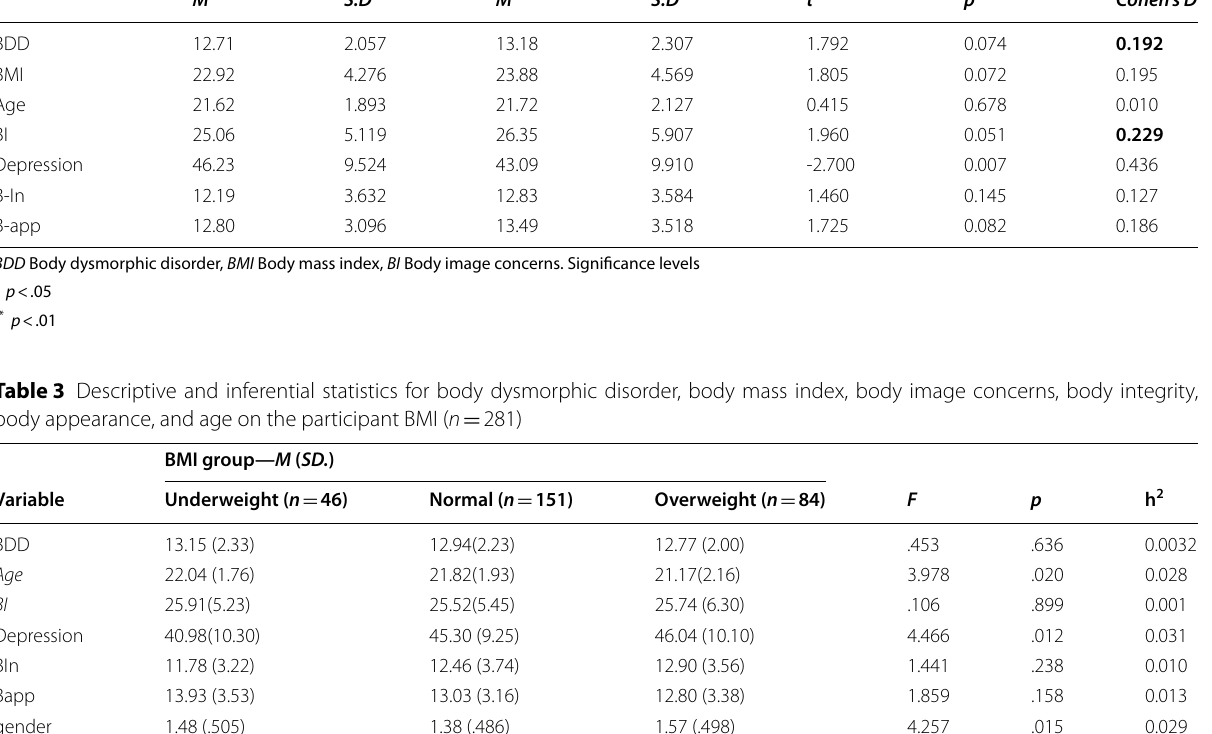
Significance levels: * p < .05, ** p <